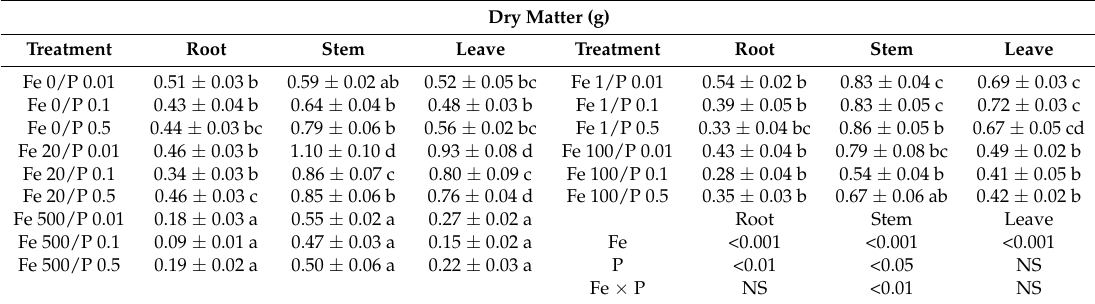
Table 2. Dry matter of G. spiculosa exposed to different concentrations of Fe and P (mean ± SE, n = 5), and the analysis of variance (two-way ANOVA) on dry matter. Dry Matter (g) Treatment Root Stem